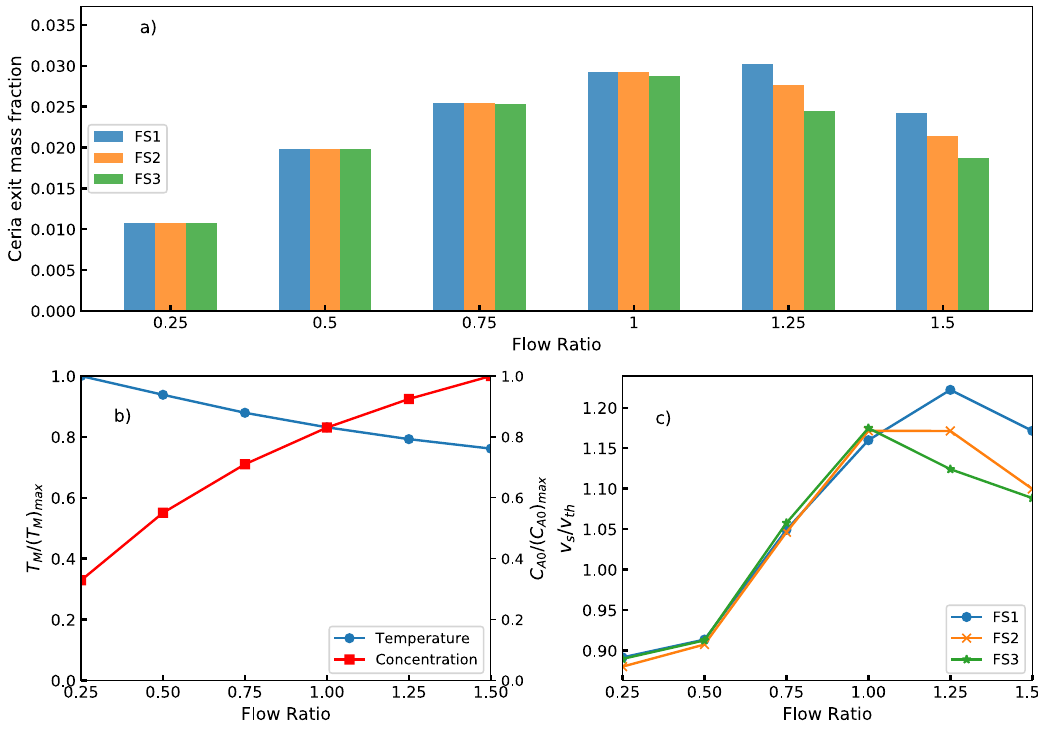
Figure 9. Consolidated view of key reaction parameters for all the flow sets and flow ratios: ( a ) comparison of ceria exit concentration, ( b ) normalized reaction mixture temperature and cerium nitrate concentration, and ( c ) scaled threshold